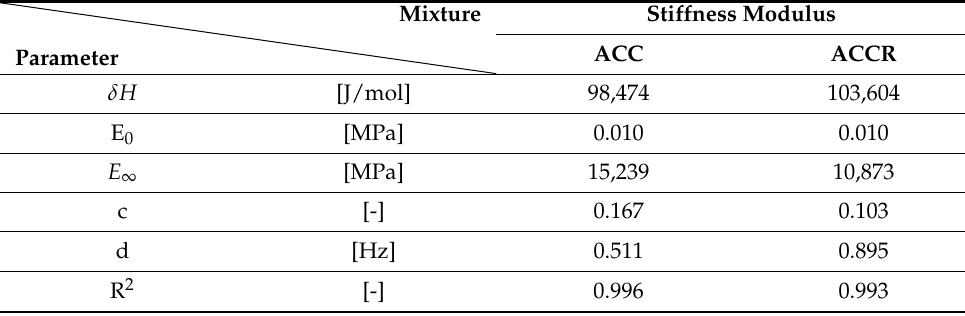
Table 5. Parameters of phase angle master curve θ , Equation (7).